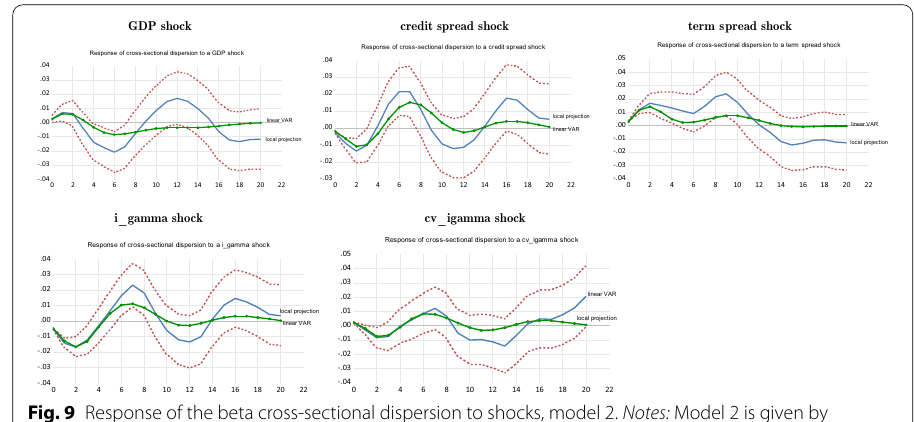
Fig. 9 Response of the beta cross‑sectional dispersion to shocks, model 2. Notes: Model 2 is given by equation (22). The impulse response functions corresponding to the linear LP—i.e., the beta cross‑sectional dispersion forecast following external shocks—are built using the Jordà’s (2004, 2005, 2009) algorithm provided by Eren Ocakverdi, consultant at Yapy Kredi. The local projection of the beta cross‑sectional dispersion is performed over the subprime crisis (2007Q3–2009Q4). We also provide the linear VAR estimated over the whole sample period selected as benchmark. The confidence interval of the LP impulses, computed at the threshold of 95%, is in dotted